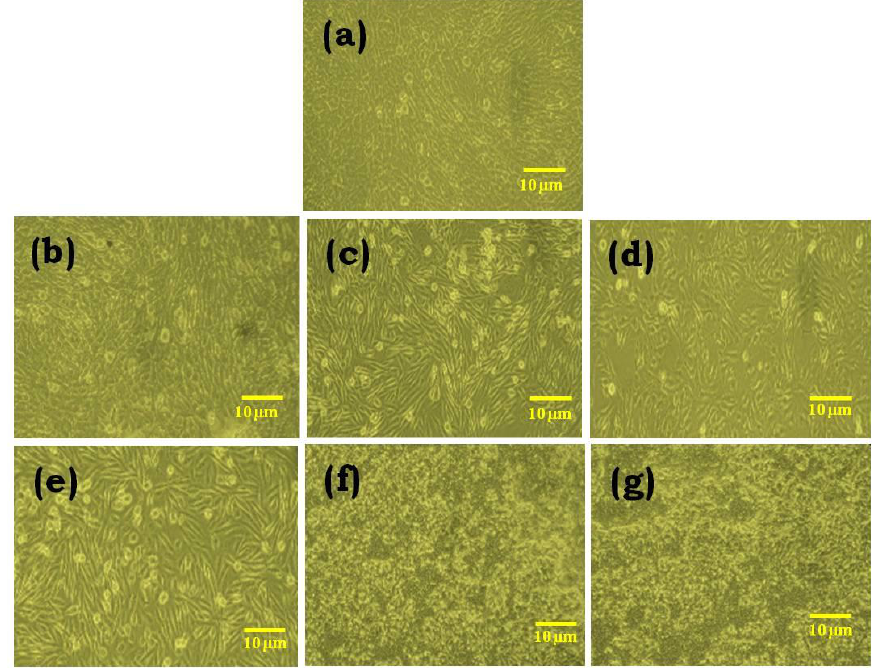
Figure 12. Cytotoxicity Assay of GO and rGO-based composite gels on NIH 3T3 cell line. ( a ) control; ( b ) hydrogel; ( c ) hydrogel + GO; ( d ) hydrogel + rGO; ( e ) aloe vera gel; ( f ) aloe vera gel + GO; ( g ) aloe vera gel + rGO.